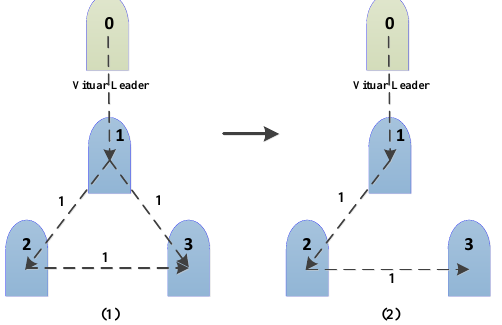
Figure 3. The augmented graph of information transfer in the